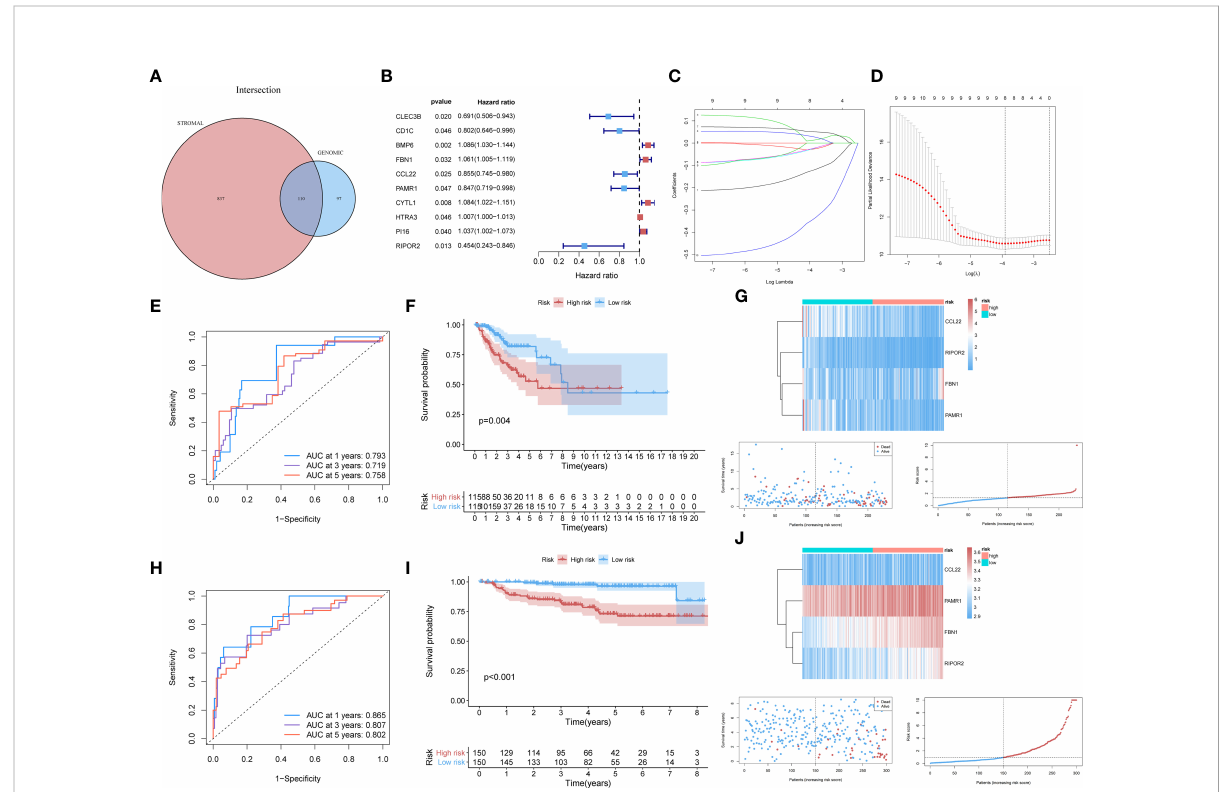
FIGURE 2 (A) The 110 common genes in the intersection analysis of GIRGs and Stromal-Related DEGs. (B) 10 prognostic intersection genes fi ltered out by the univariate Cox analysis with the p-value of <0.05, inclusive of CLEC3B, CD1C, BMP6, FBN1, CCL22, PAMR1, CYTL1, HTRA3, PI16, RIPOR2. (C, D) Inferred from the 10-folded LASSO regression results, four signatures were screened out: CCL22, FBN1, RIPOR2, and PAMR1. (E – G) Survival distribution-related analyses for the TCGA cohort. (E) Survival at 1, 3, and 5 years was drawn in ROC curves. The areas under the curves